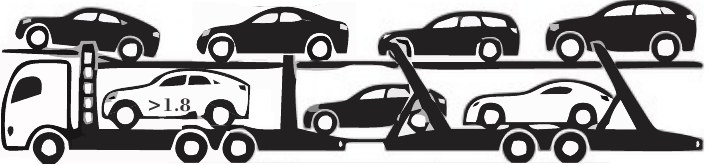
Figure 6. Constraint of vehicles with 1.8m < h < 2.5 m.